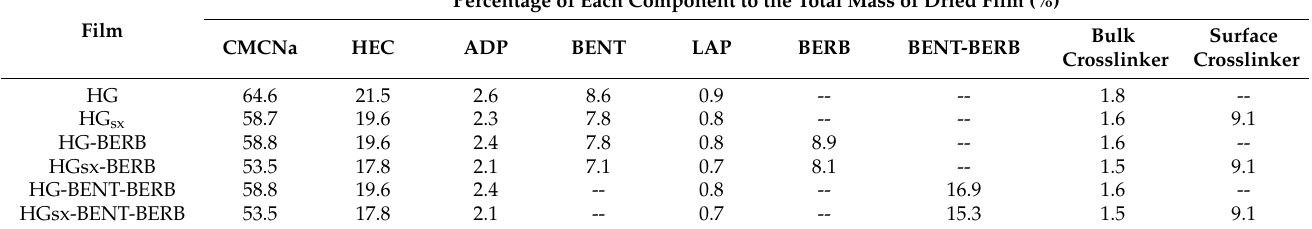
Table 2. Hydrogel films